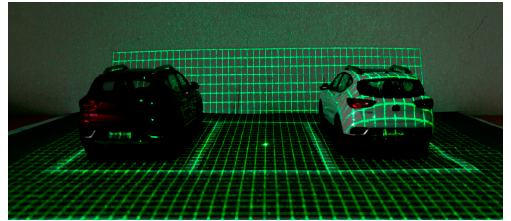
Figure 18. Gamma-enhanced image.